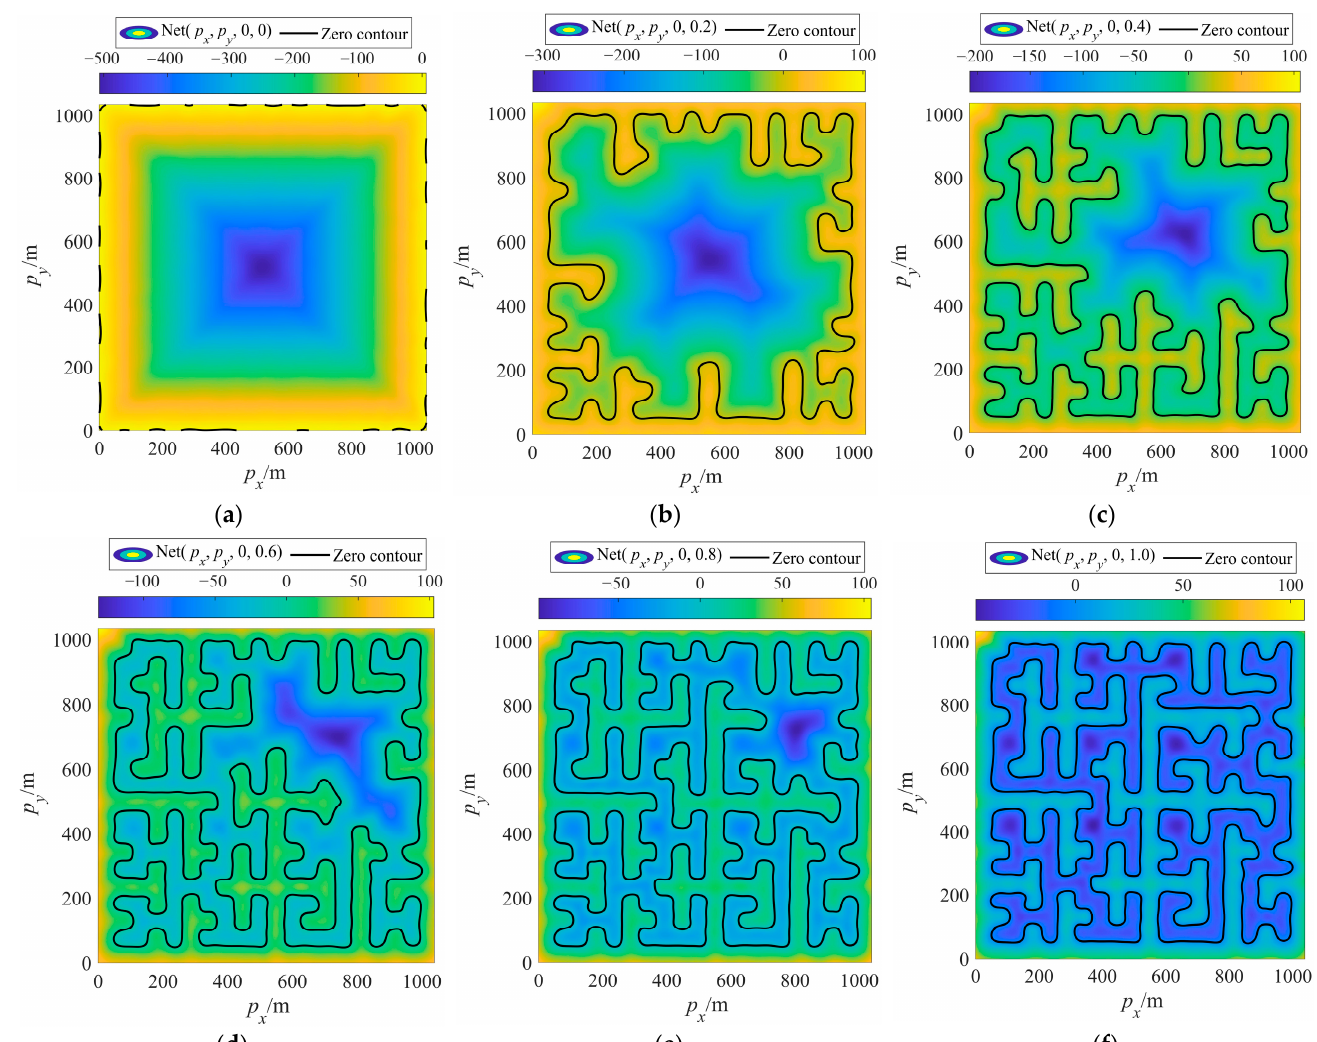
Figure 9. Example 2 ′ s MSD field with different homotopy parameters. ( a ) ε= 0.0 , ( b ) ε= 0.2 , ( c ) ε= 0.4 , ( d ) ε= 0.6 , ( e ) ε= 0.8 , and ( f ) ε= 1.0 .